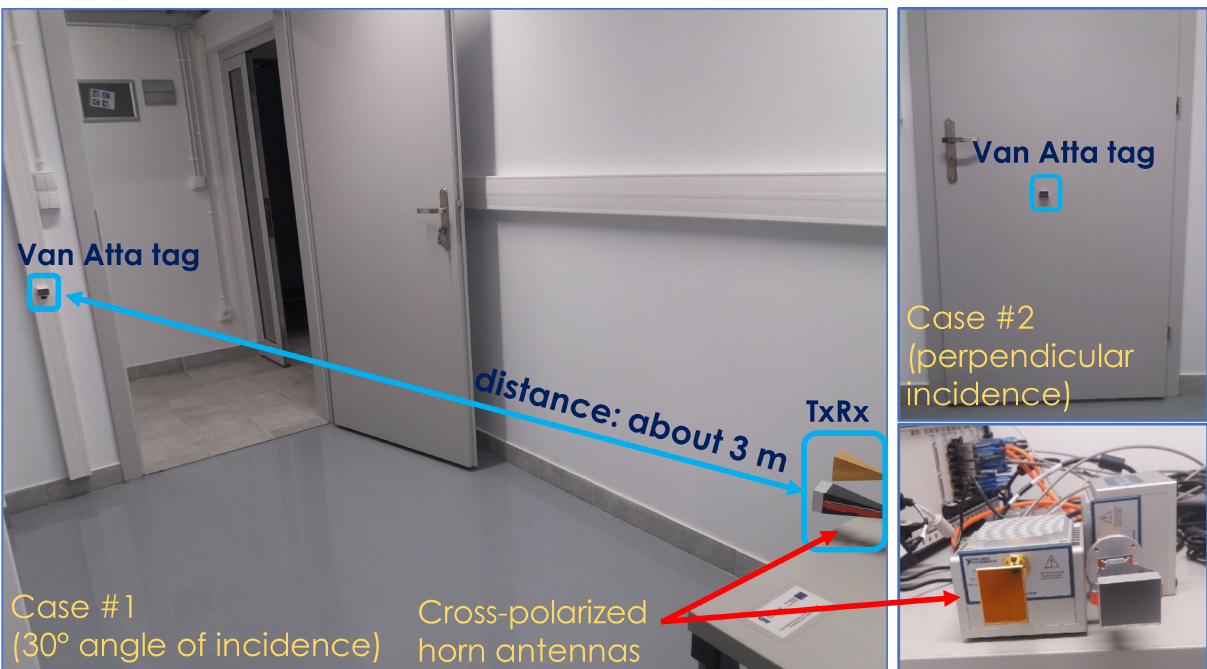
Figure 8. The measurement setup in the indoor environment.